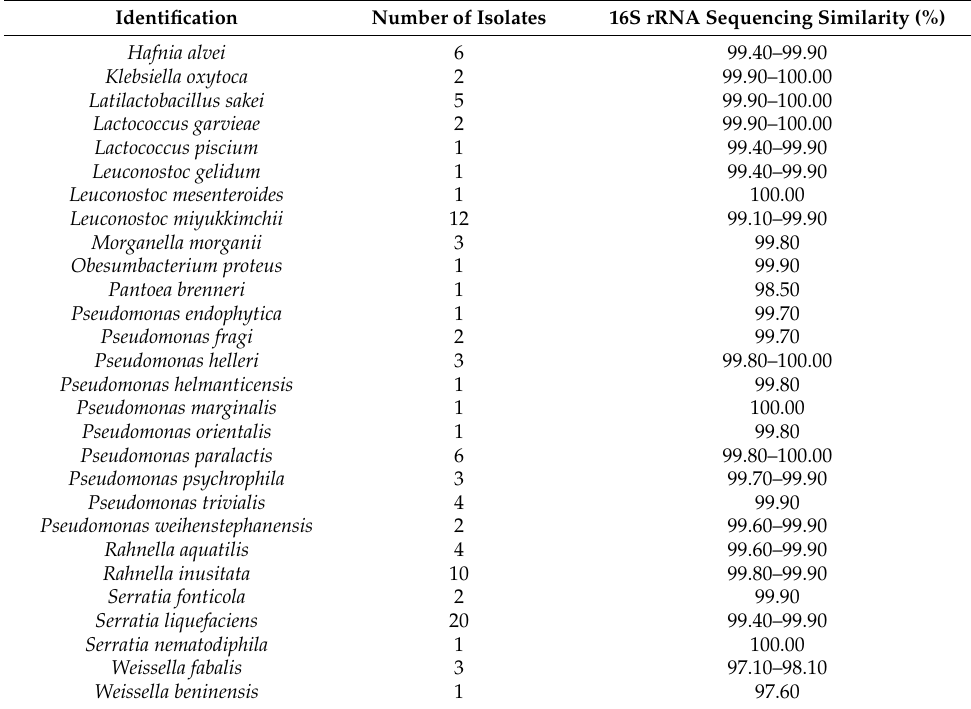
Table 3. Identification of 100 isolates by 16S rRNA